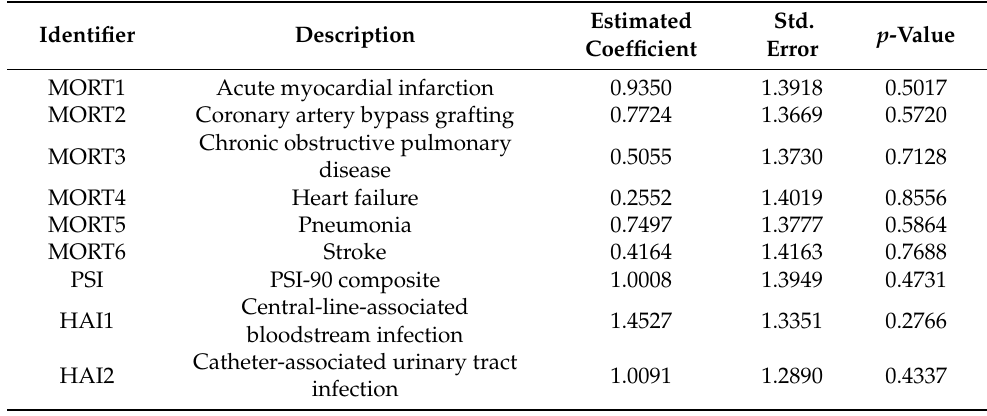
Table 3. Results of a multivariate multinomial ordered probit model assessing the association between MSPB and all 15 outcome measures across five quality domains ( n =